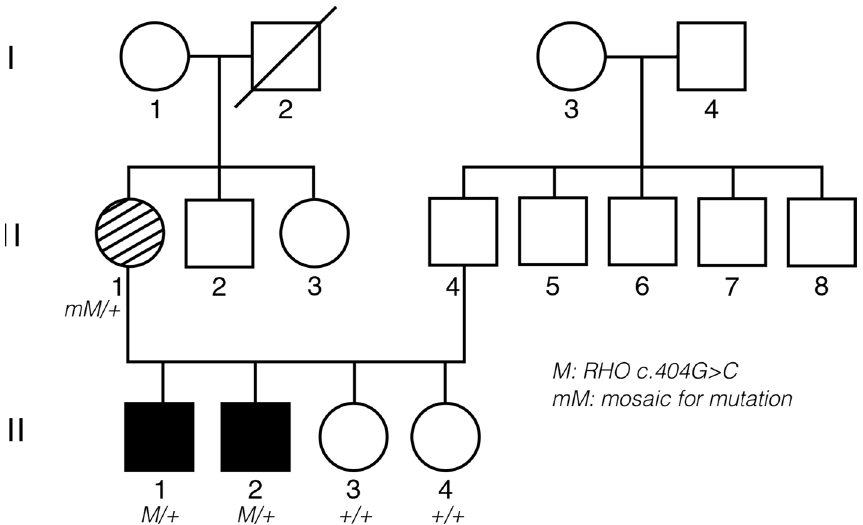
Figure 1. Pedigree of the family and segregation analysis of the RHO variant. Filled symbol: affected individual. Striped symbol: mildly affected female, mimicking carriership of XLRP. M/ + : heterozygous RHO variant c.404G > C p.(Arg135Pro). + / + : homozygous wild type. mM/ + : mosaicism for c.404G > C